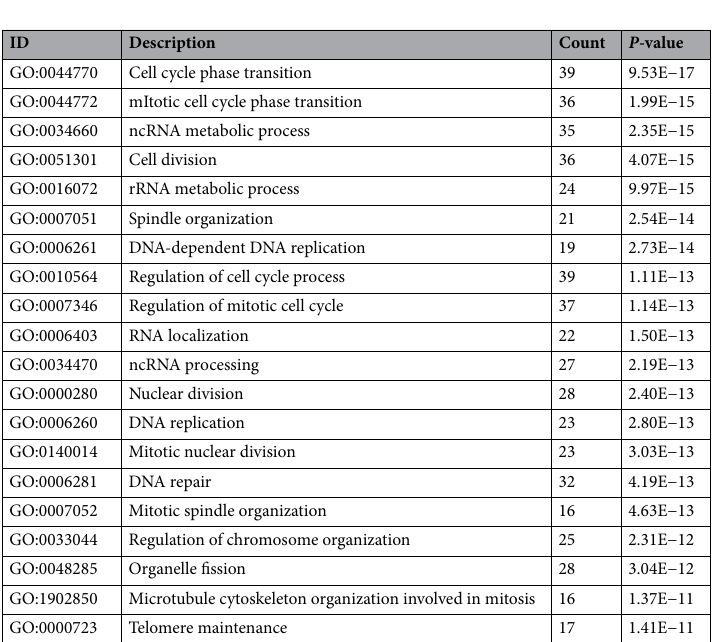
Table 3. The 20 GO Terms (BPs) with the smallest P-value in the key gene module (m1) identified by GCNA- Kpca